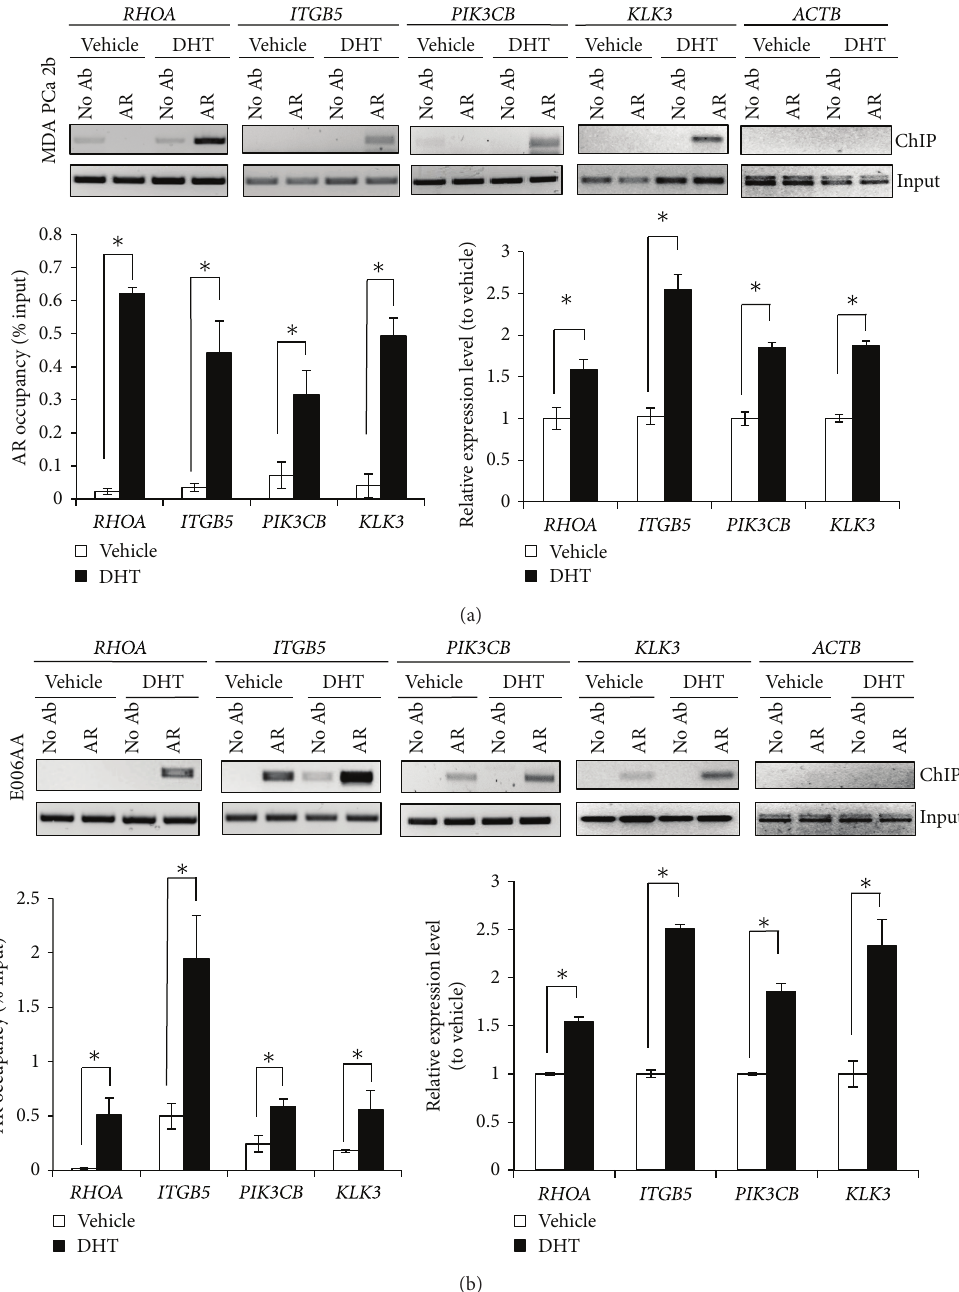
F 4: Androgen stimulation increases AR occupancy at target genes and upregulates AR-target gene expression in AA PCa cells. (a) AA PCa cell line MDA PCa 2b and (b) AA PCa cell line E006AA were treated with 100nM DHT for 18hr (top panels). Representative ChIP-PCR assays con�rmed DHT-induced increases in AR occupancies at the promoter regions of RHOA, ITGB5, and PIK3CB genes. AR occupancies and relative gene expressions with or without androgen stimulation (bottom panels) were measured as a percentage of ChIP-to-Input signal and mRNA levels, respectively. KLK3 ( PSA gene) and ACTB were used as positive and negative controls for the ChIP-PCR assays, respectively. For qRT-PCR, the relative expression levels of RHOA , ITGB5 , PIK3CB, and KLK3 were determined by the PPA1 as endogenous genes for normalization. Cells were treated with a vehicle ( ChIP and qRT-PCR assays. Data are represented as the mean AR occupancies and expression levels of AR-target genes in both cell lines (